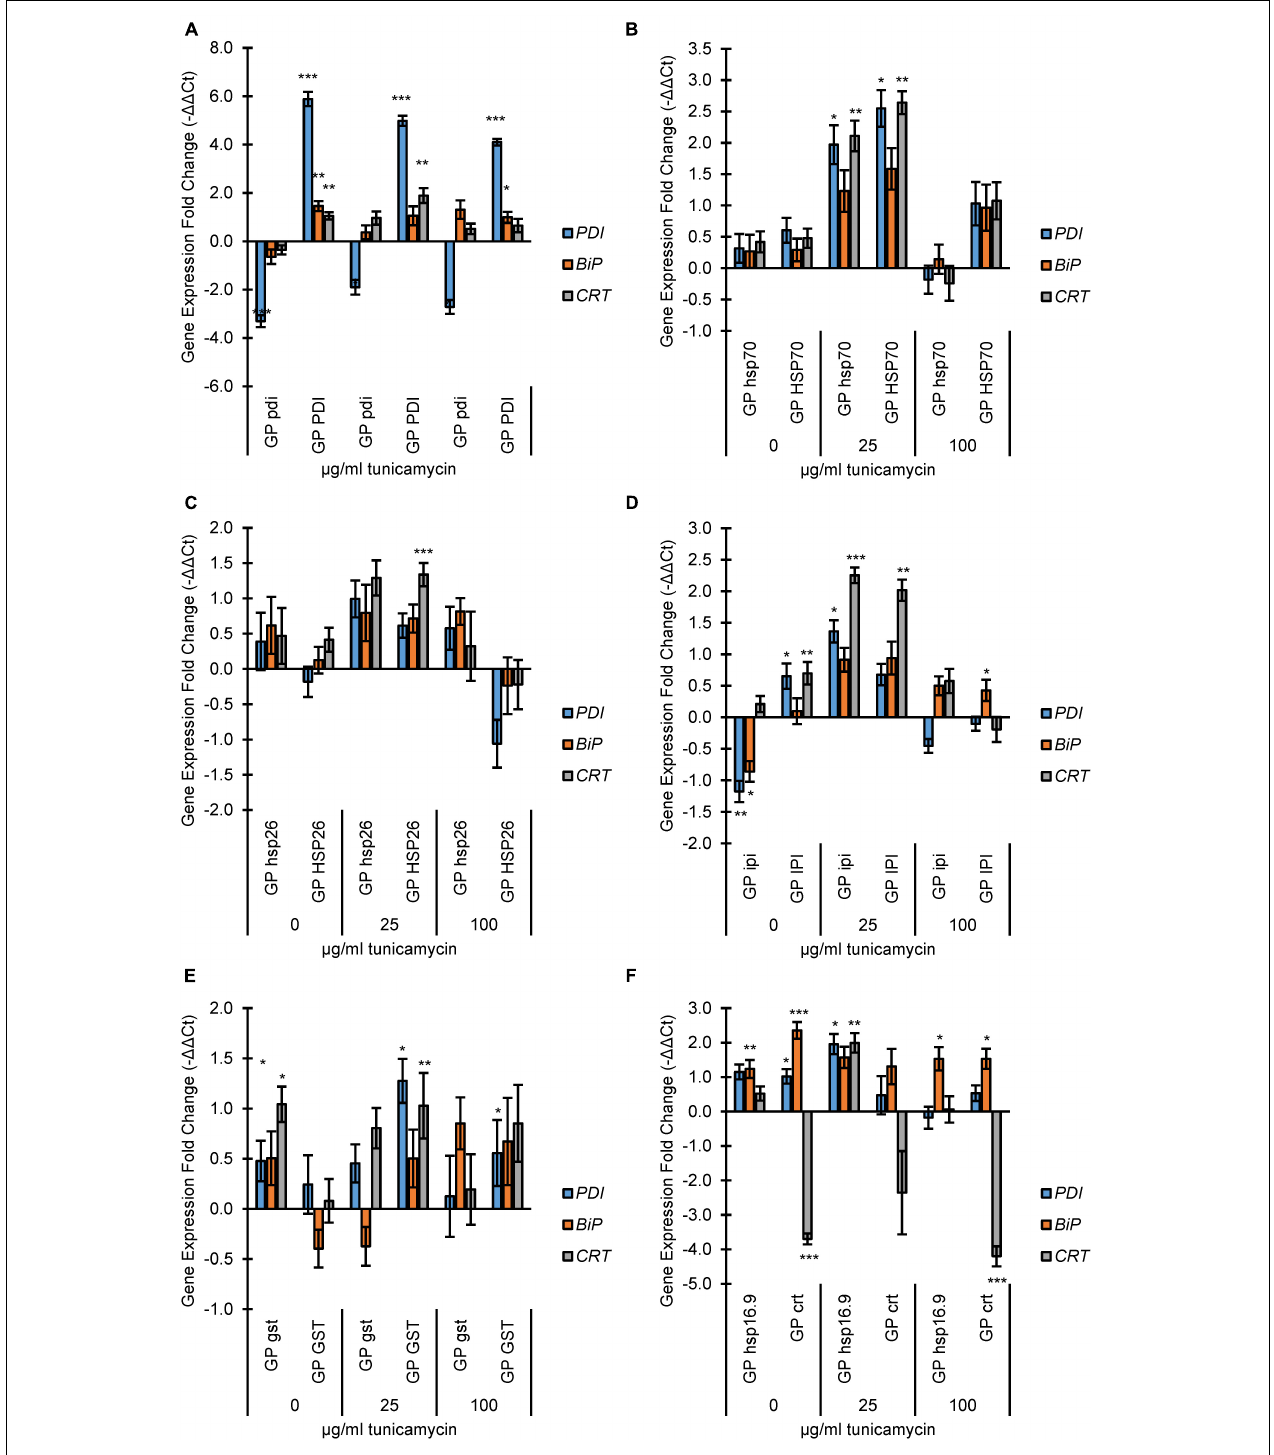
FIGURE 1 | Endoplasmic Reticulum (ER)-stress analysis of mutant and overexpression lines by fold change expression of UPR genes protein disulfide isomerase ( PDI ), protein binding immunoglobulin protein ( BiP ), and calreticulin ( CRT ). The qRT-PCR samples were normalized to the expression level of two reference genes actin and GAPDH . The expression fold change levels were determined relative to Golden Promise expression at each TN concentration on a log 2 scale (i.e., – (cid:49)(cid:49) C T ). Incubation concentrations of TN were 0, 25, or 100 µ g/ml. (A) PDI lines; (B) HSP70 lines; (C) HSP26 lines; (D) IPI lines; (E) GST lines; (F) koHSP16.9 and koCRT lines. The error bars represent the standard error and Student’s t -test was applied to find any significant changes in expression between Golden Promise and mutant lines. * p < 0.05, ** p < 0.01 and *** p < 0.001.